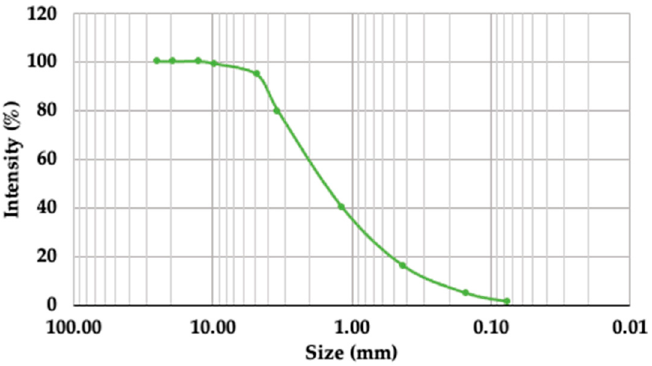
Figure 2. Sieve analysis for commercially sand used in the sand/plastic cobbles. The sand was previously baked dry for 24 h and sifted with particle sizes of <1.00 mm diameter as is suggest in previous results [32].